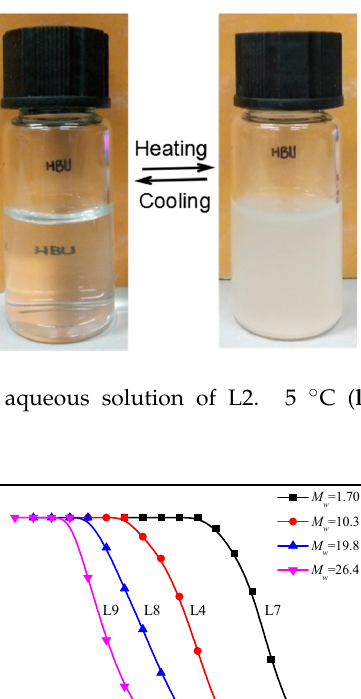
Table 5. Effect of DB% on LCST of HPNPAMs.